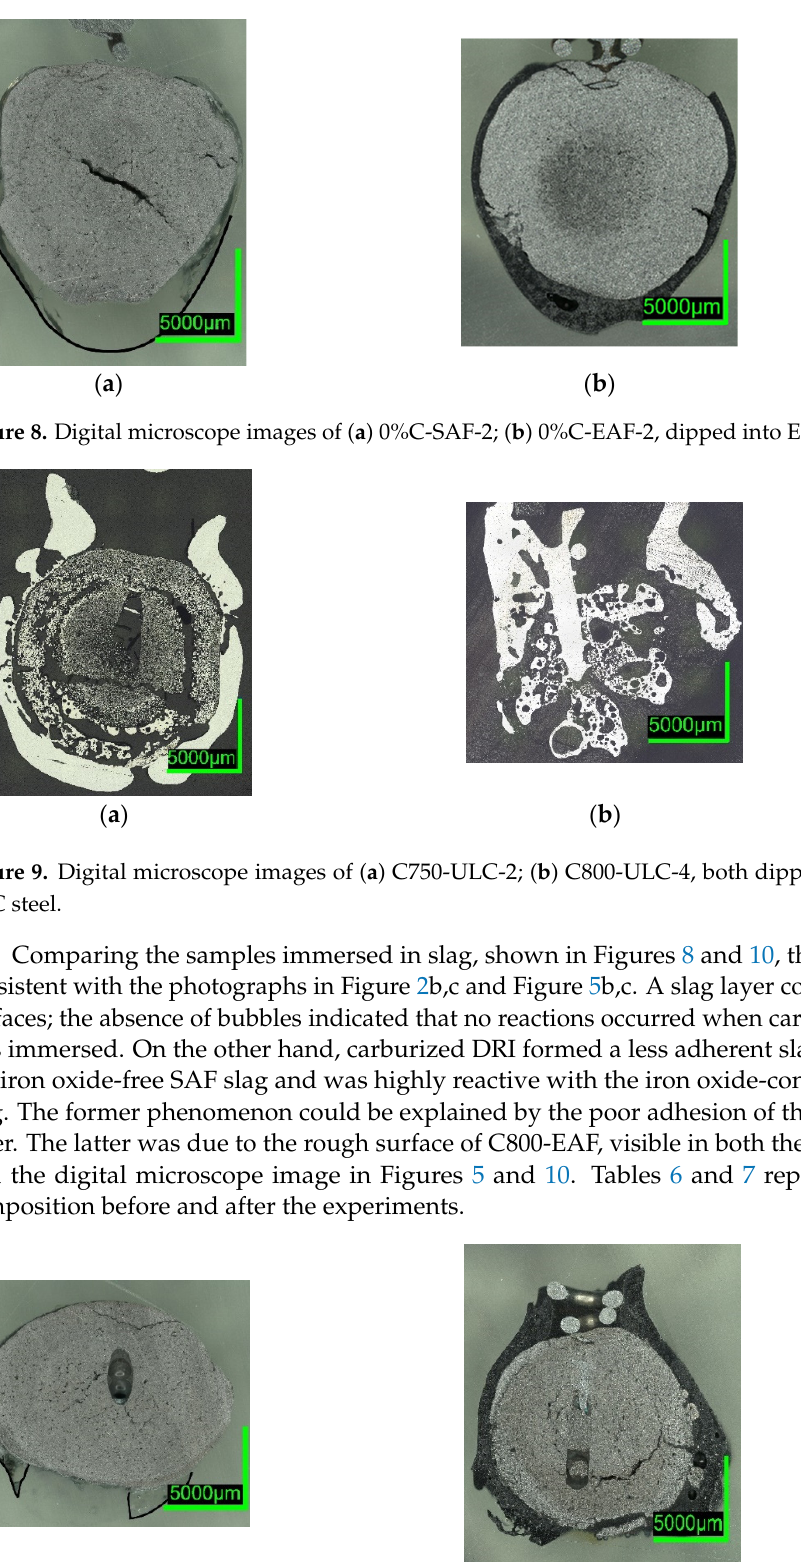
Figure 11. Digital microscope images of the HBI-ULC-2-1 sample, dipped into ULC. Heat Transfer Conditions For comparing the slag and the ULC immersion tests, differences in the heat transfer conditions should be considered. While the slag temperature in the C800-SAF test was 1479 °C, the liquidus temperature of iron with 3.79% carbon was approx. 1213 °C, calcu- lated by FactSage™ 8.0 using FSStel Database. This resulted in a significant superheating of 266 °C. As in Figure 8 no melting of the pellet can be noticed, the heat transfer could be limited when DRI became in contact with the non-reactive slag. In the scope of a similar study, Sadrnezhaad and Eliot [47] described a solid adherent slag layer. Using inert nickel